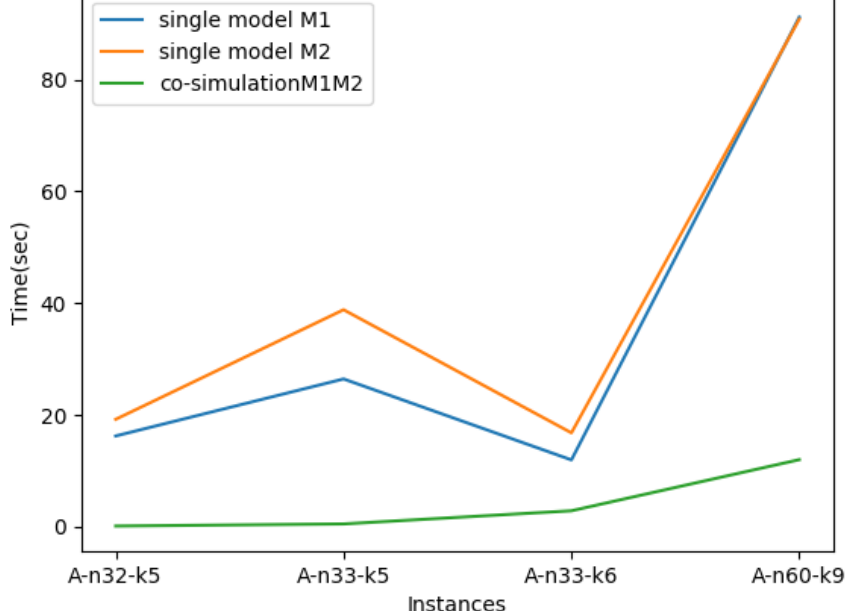
Figure 7. The execution time of co-simulation models M 1 with M 2